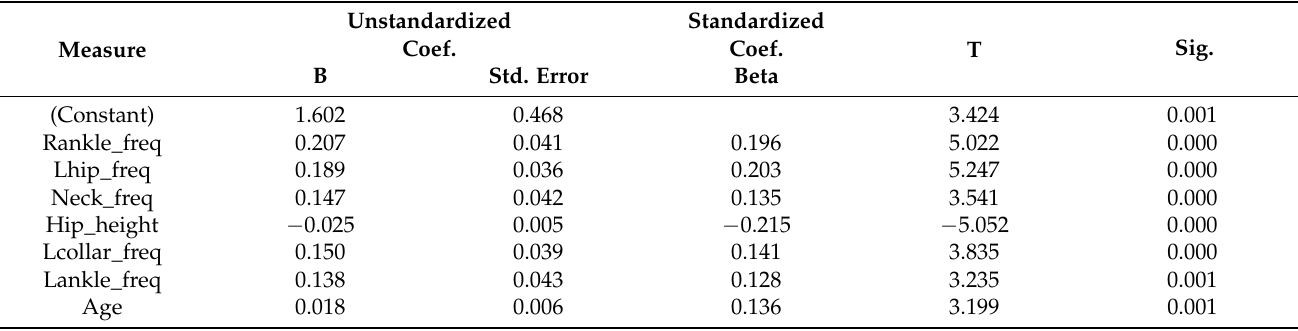
Table 10. Results of Stepwise Regression of SD_hip (Freq.